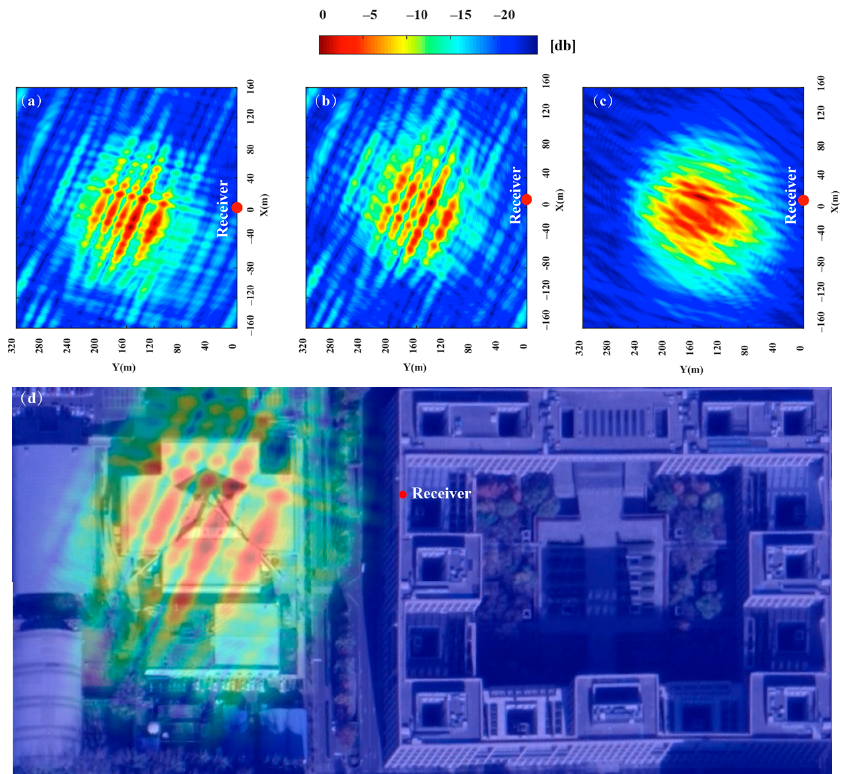
Figure 16. Dual-satellite fusion image: ( a ) fusion image of PRN15 and PRN12, ( b ) fusion image of PRN15 and PRN24, ( c ) fusion image of PRN12 and PRN24, ( d ) dual-satellite image and optical image (Google Map) matching.